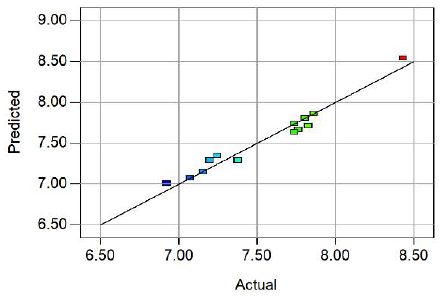
Figure 5. Residual distribution diagram of the response variable. ( a ) Internally studentized residuals vs. run number (The red line is the residual range line). ( b ) Normal probability vs. internally studentized residuals (The red line is the residual regression line).